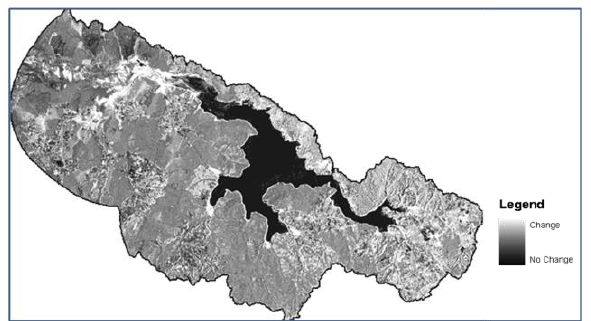
area. The colatitude vector direction is the vector